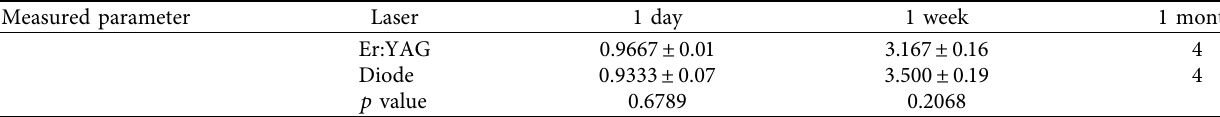
Table 7: Wound healing of Er:YAG compared to diode lasers.